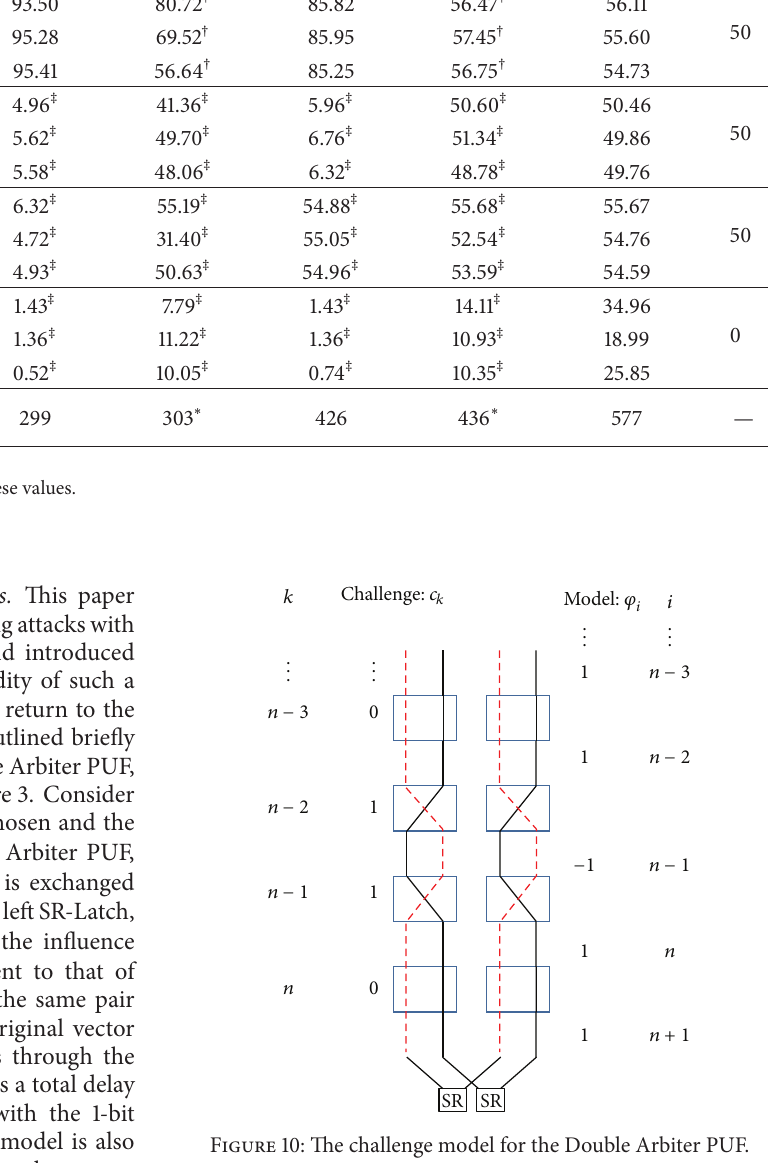
10,000 responses from the 2-XOR Arbiter PUFs on all